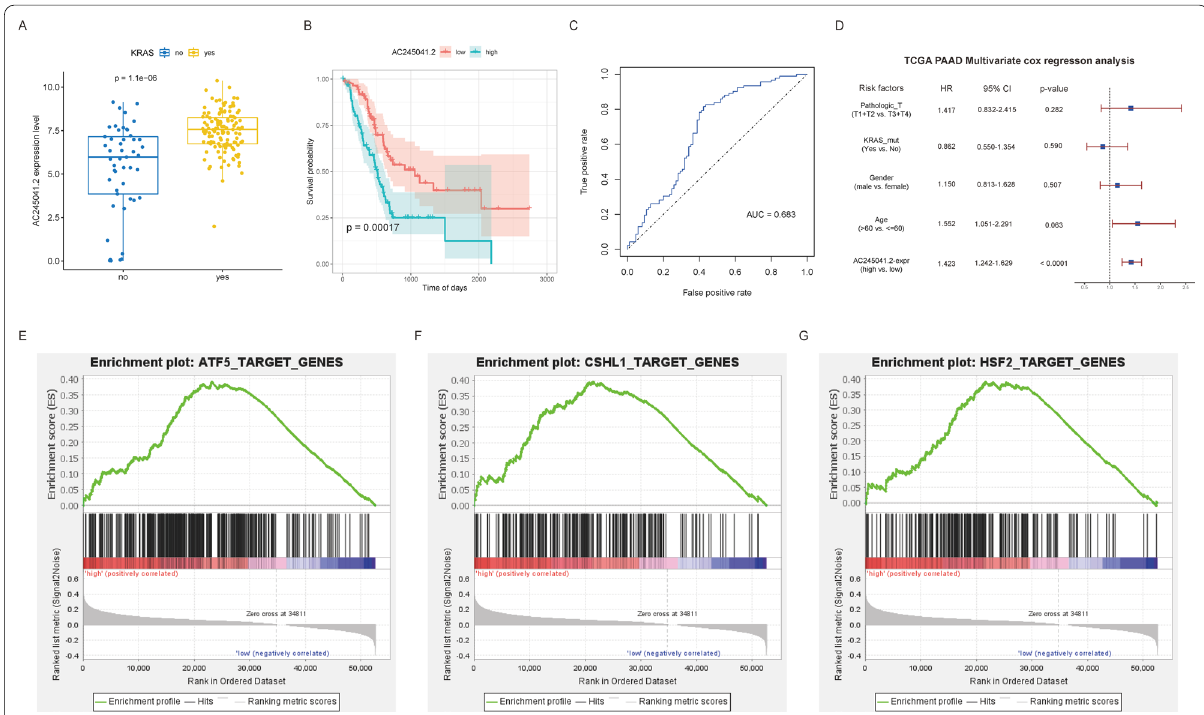
Fig. 11 A Distribution of AC245041.2 expression in KRAS mutation groups. B KM curves to compare the overall survival between high-AC245041.2 and low-AC245041.2 samples. C ROC curve for prognosis based on AC245041.2 expression. D Multivariate Cox regression analysis based on